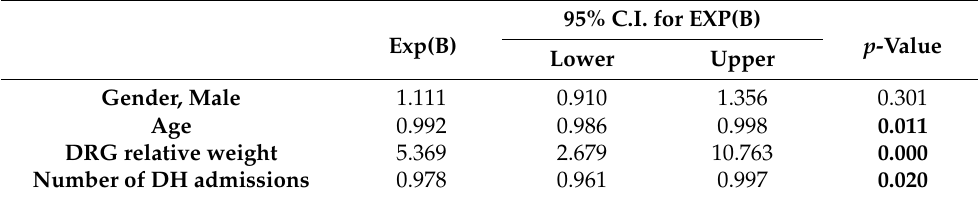
Table 6. Logistic regression—Patients with DH admissions.